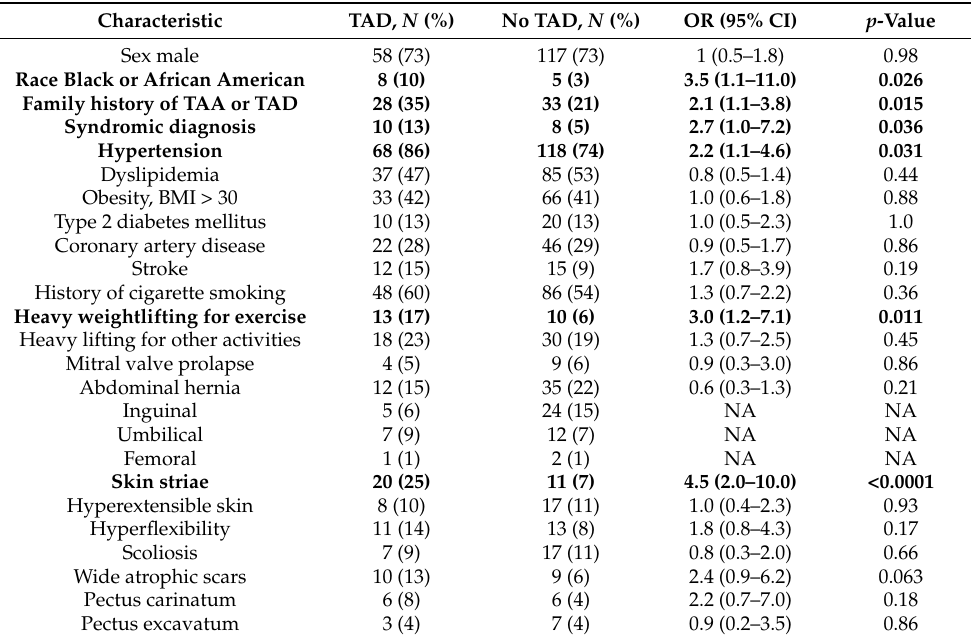
Table 3. Comparison of clinical and connective tissue characteristics between cases with thoracic aortic dissection (TAD) ( N = 80) versus cases without TAD ( N =